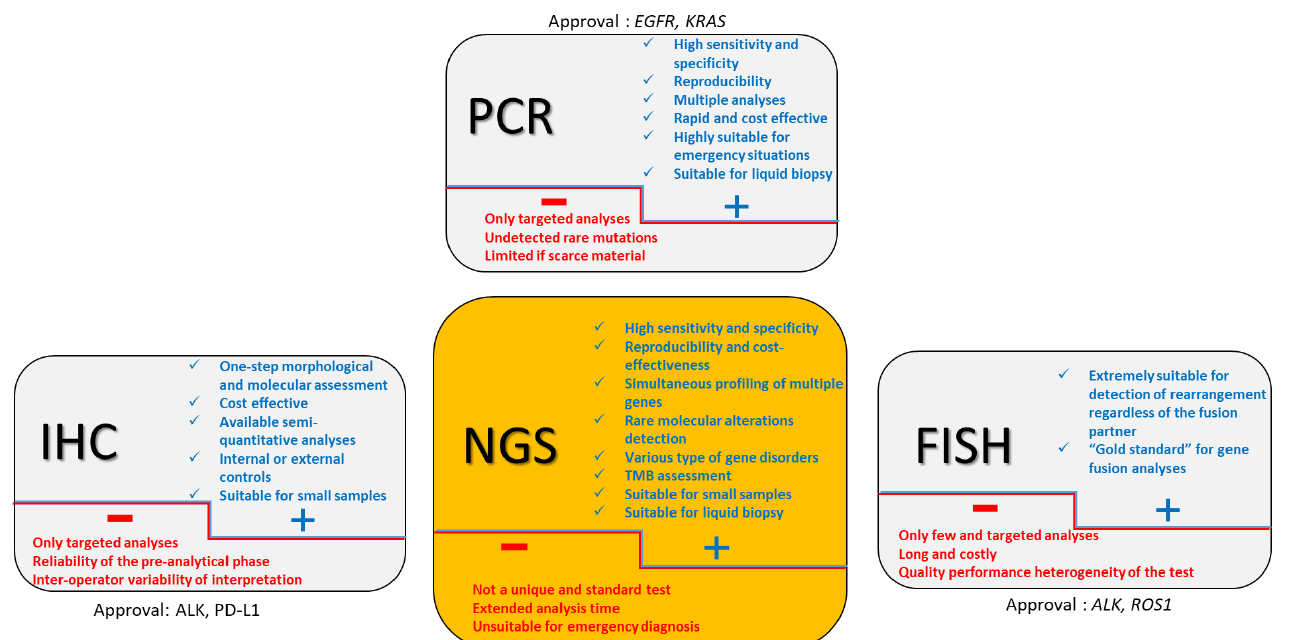
Figure 1. Approved diagnostic tools in lung cancer. Strengths and weaknesses of diagnostic tools appear respectively in blue and red font.